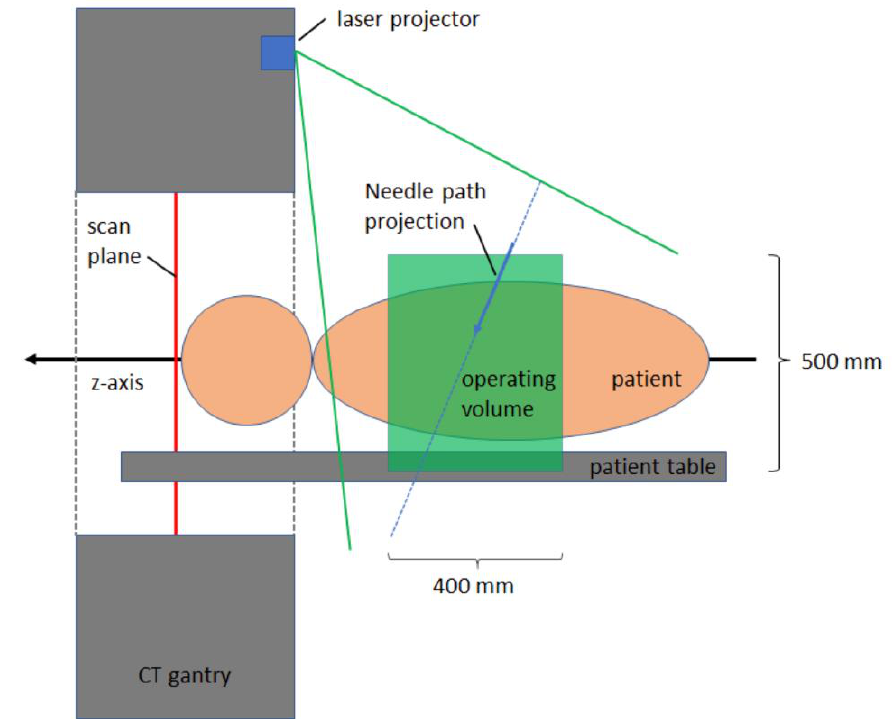
Figure 3. Schematic of needle path projection in front of the gantry onto the operating volume. Within the operating volume, a visualization of needle paths is possible.